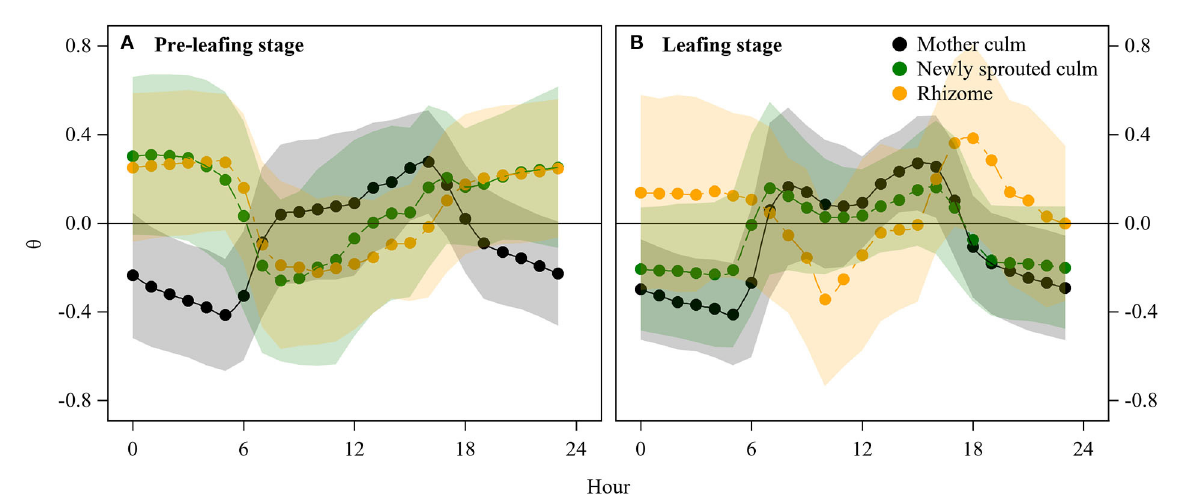
FIGURE4 Diurnal hourly sap flow direction shifts before (A) and after (B) leafing of the newly sprouted culms. For the mother and newly sprouted culms, positive and negative θ indicated upward and downward sap flow, respectively. For the rhizomes, positive and negative θ indicated sap flowing to newly sprouted and mother culms,